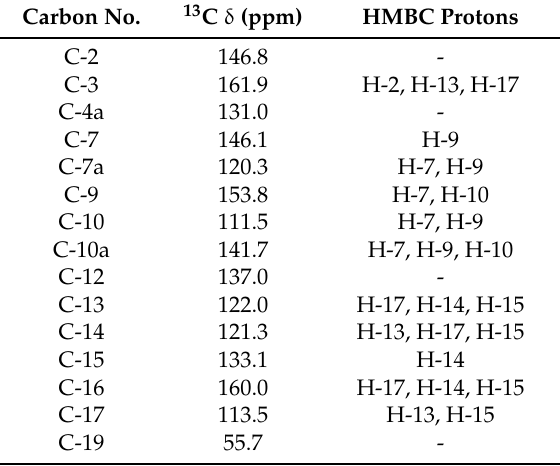
Table 5. 13 C-NMR data for 25 with long-range C/H couplings observed in HMBC spectrum. Carbon